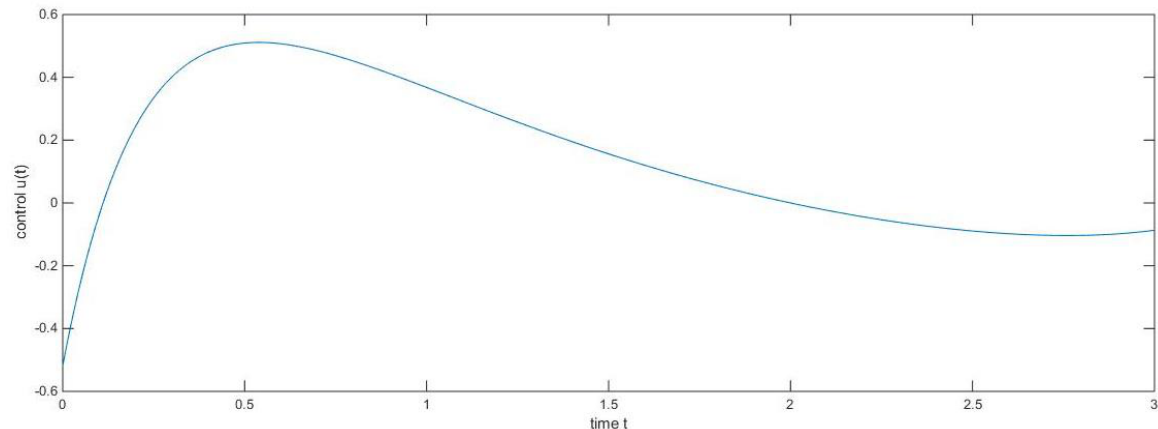
Figure 3. The steering control